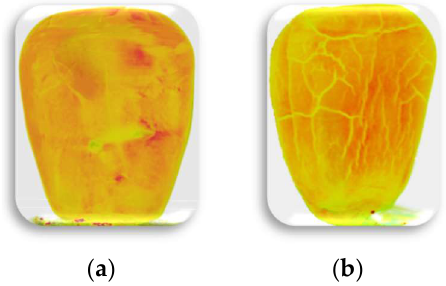
Figure 12. Dehydrated corn seed longitudinal scanned sections. ( a ). T = 40 °C; v = 2,5 m/s; ( b ). T = 80 °C; v = 1 m/s. v = 1